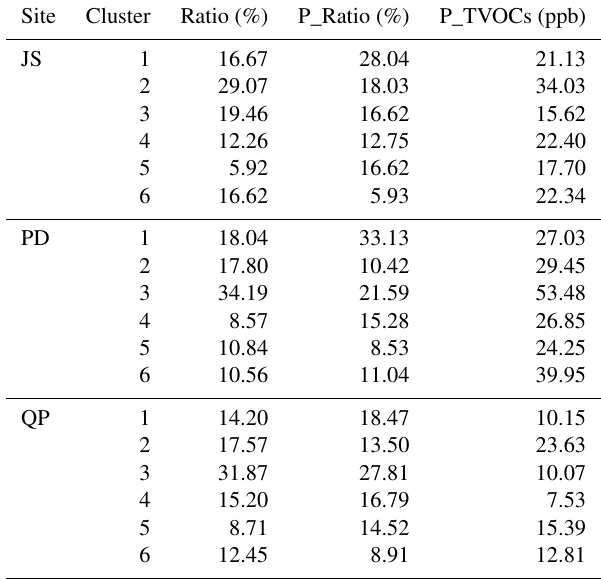
Table 1. Air mass cluster trajectories at the JS, PD and QP